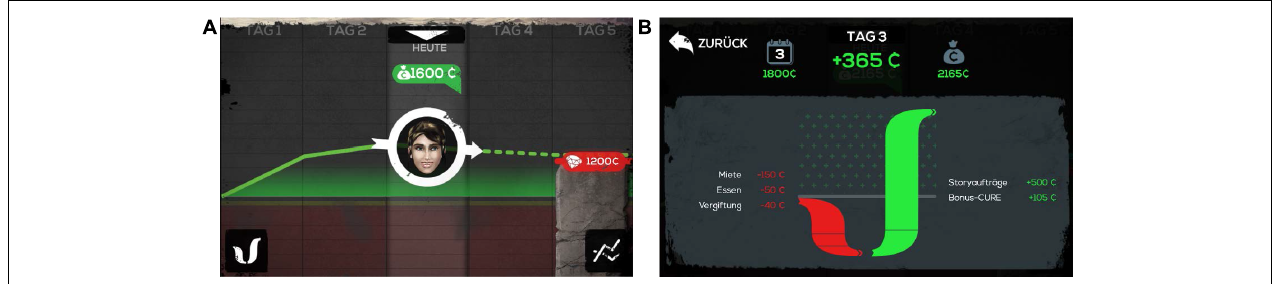
FIGURE 2 | Example screenshots of (A) statistics screen with projection toward savings target and (B) balance sheet screen in Cure Runners (published with permission from Three Coins).